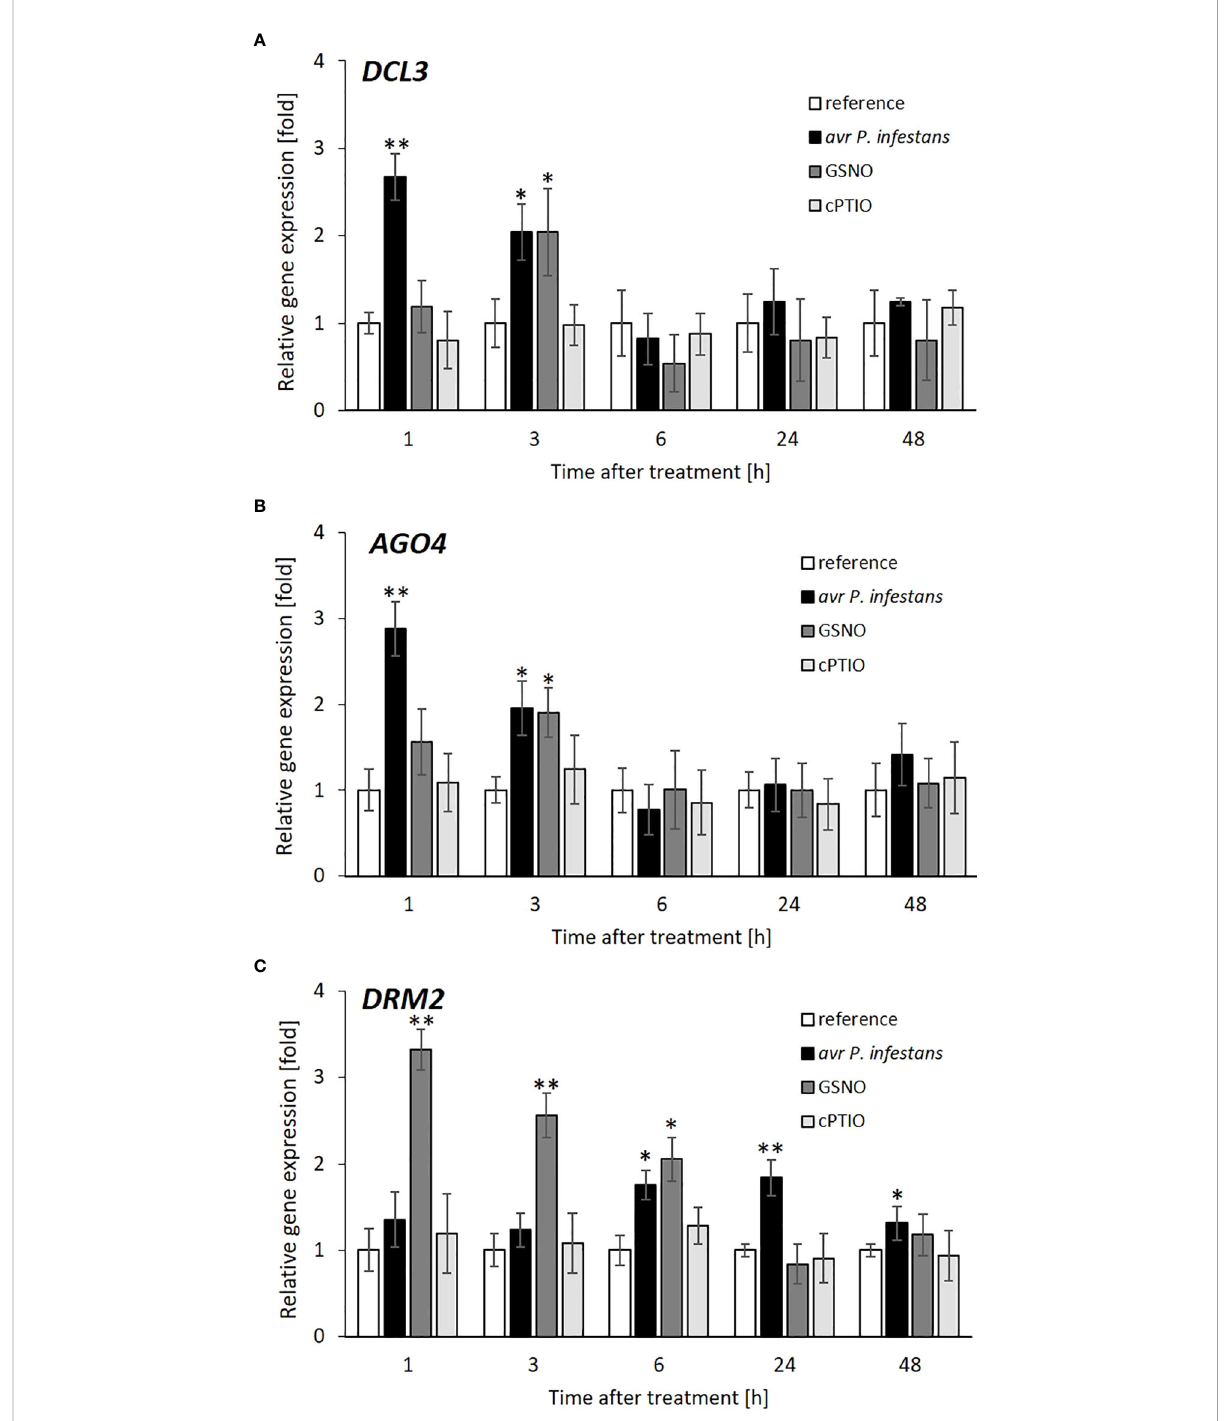
FIGURE 5 Effect of avr P . infestans or GSNO on RdDM pathway. RT-qPCR analysis of the DICER ( DCL3 ) (A) , ARGONAUTE ( AGO4 ) (B) domains rearranged methyltransferase 2 ( DRM2 ) (C) , respectively, were performed at selected time points at 1-48 h after GSNO, cPTIO treatment or challenge inoculated. There were no signi fi cant changes in the absolute values of the analyzed transcript levels after the leaves spraying with water. Values represent the means of data ± SD of at least three independent experiments. Asterisks indicate values that differ signi fi cantly from water-treated (reference) potato leaves at a <0.05 ( ∗ ) and a <0.01 ( ∗∗